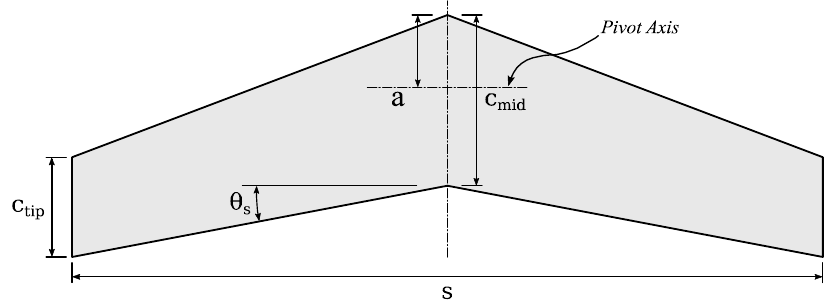
Figure 8. Planform of hydrofoil. The foil is swept by an angle θ s .